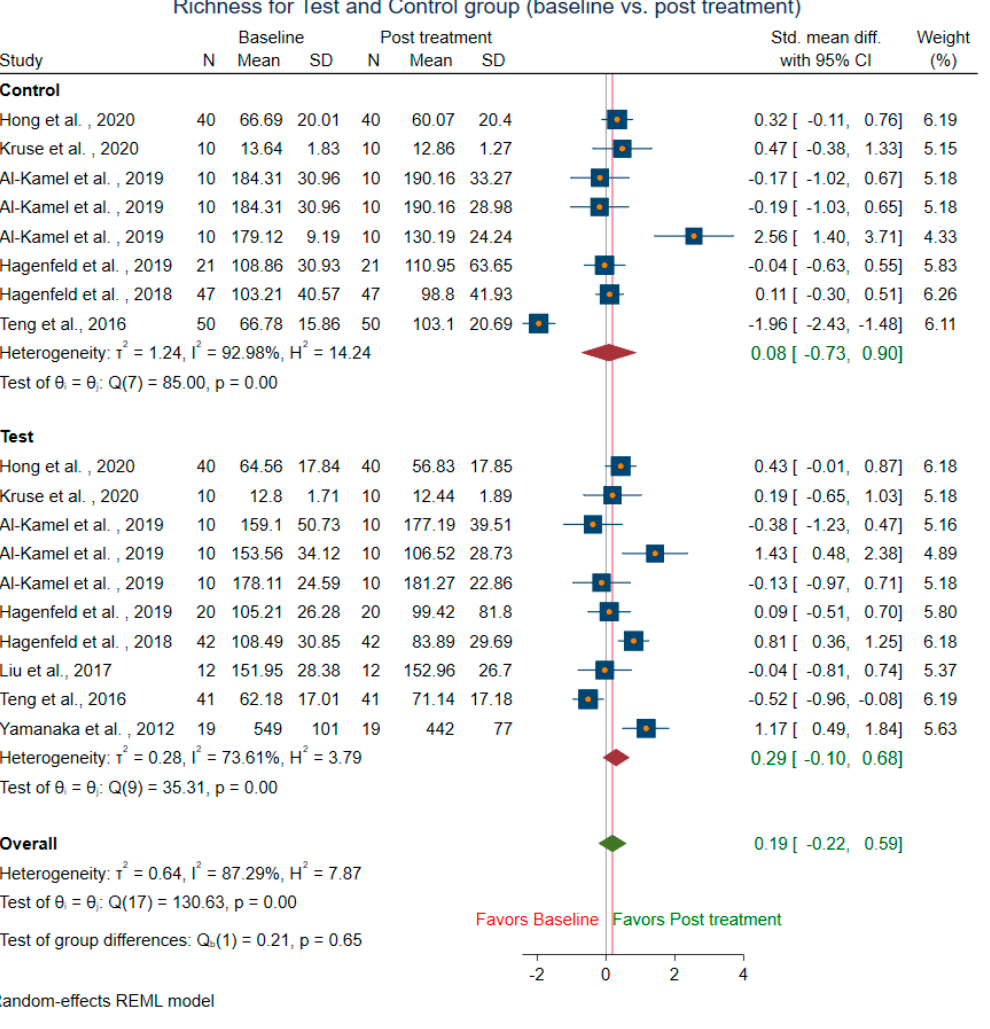
Figure 4. Subgroup meta-analysis of richness based on test subgroup (baseline vs. post-treatment) and control subgroup (baseline vs. post-treatment).